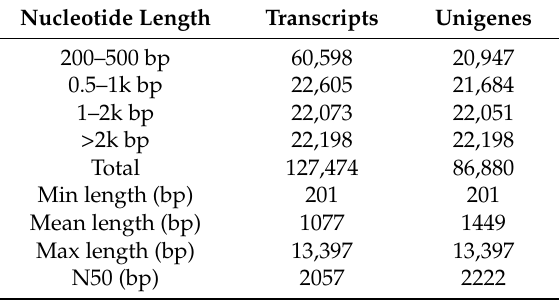
Table 1. Length distribution of unigenes and transcripts.